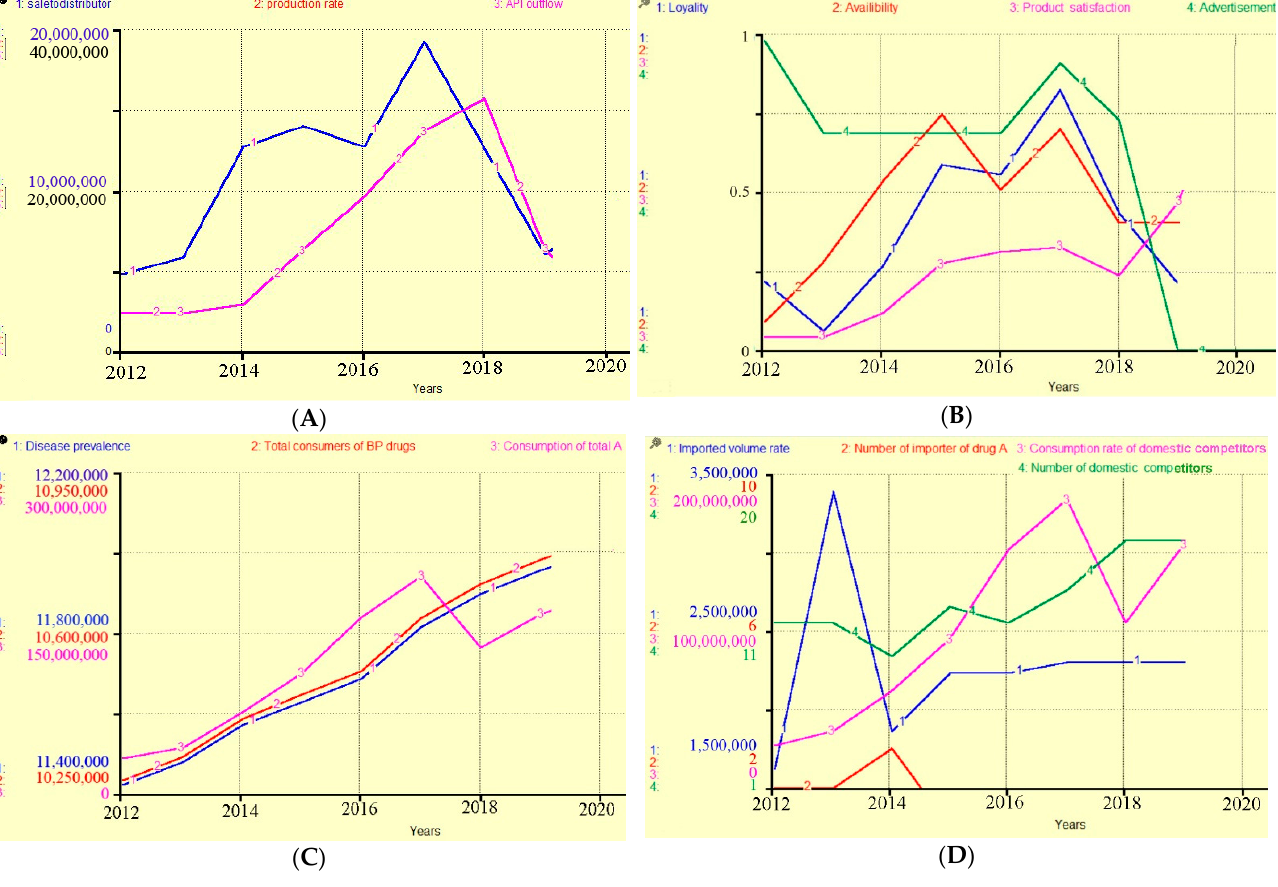
Figure 3. System dynamic simulation result during 2012–2019: ( A , B ) supplier subsystem; ( C ) demand subsystem; ( D ) competition